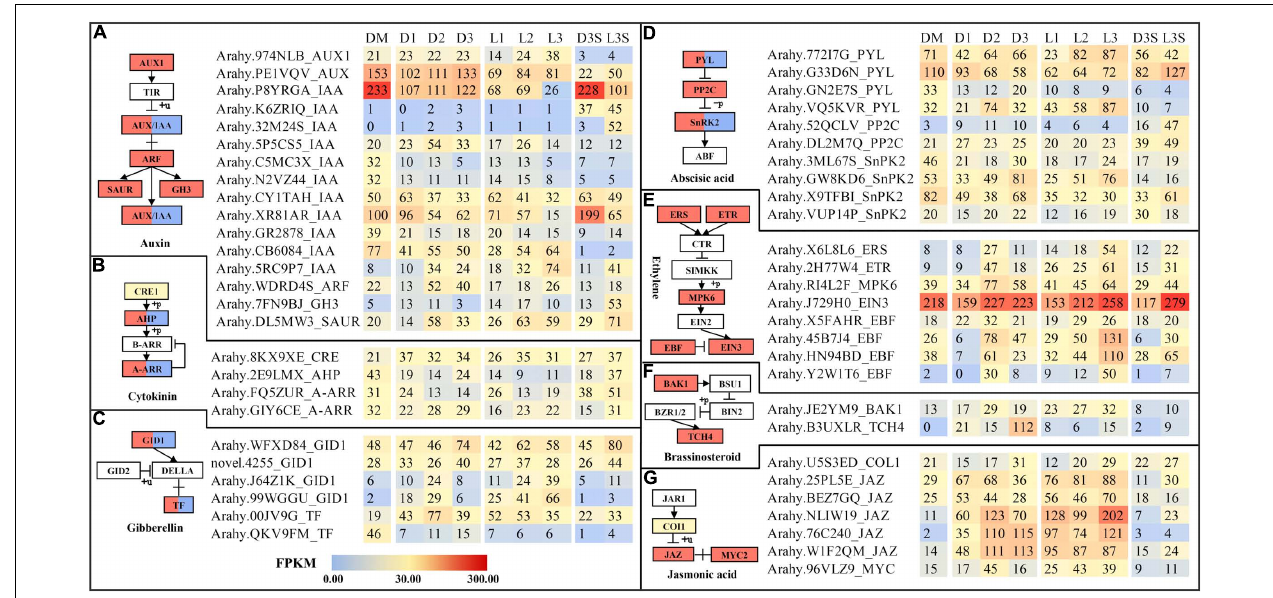
FIGURE 5 | DEGs related to plant hormone signal transduction. (A) DEGs related to auxin signal transduction; (B) DEGs related to cytokinin signal transduction; (C) DEGs related to gibberellin signal transduction; (D) DEGs related to abscisic signal transduction; (E) DEGs related to ethylene signal transduction; (F) DEGs related to brassinosteroid signal transduction; (G) DEGs related to jasmonic acid signal transduction. Only those with FPKM value ≥ 30 in at least one sample are listed; the others can be found in Supplementary Table 9 .